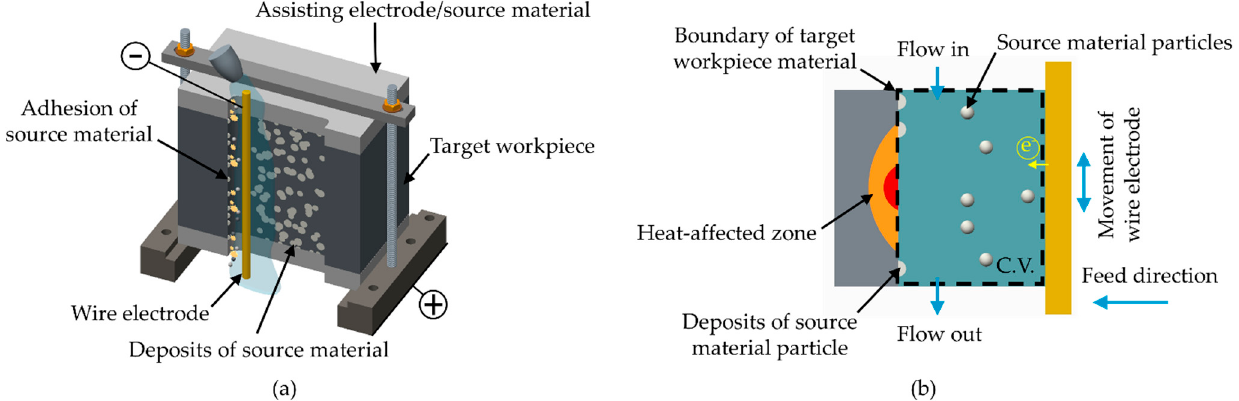
Figure 1. Schematic illustrations showing synchronized surface modification set-up: ( a ) use of assisting electrodes; ( b ) processes occurring in control volume during wire electrical discharge machining (WEDM).